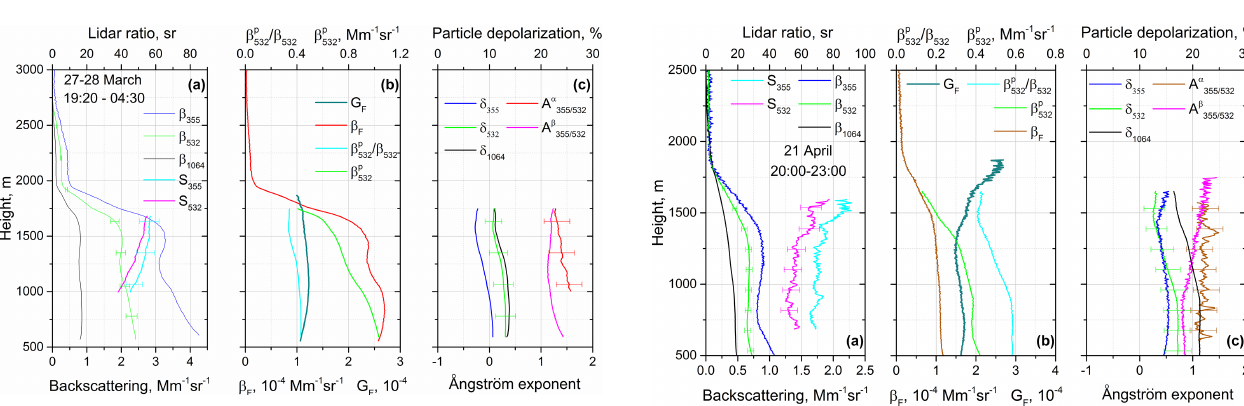
Figure 10. Vertical profiles of (a) particle backscattering coeffi- Figure 11. The same particle parameters as in Fig. 10 for 21 April cients β 355 , β 532 and β 1064 as well as lidar ratios S 355 and S 532 . 2020, 20:00–23:00UTC. Measurements were performed at 30 ◦ to (b) Fluorescence backscattering coefficient β F , fluorescence capac- the ity G F , pollen backscattering coefficient β p and its contribution to 532 β p 532 the total backscattering . (c) Particle depolarization ratios δ 355 , β 532 δ 532 and δ 1064 together with extinction A α and backscatter- 355 / 532 ing A β Ångström exponents measured on 27–28 March 2020 355 / 532 β p 532 were computed with at 19:20–04:30UTC. Profiles of β p and β 532 532 = 30% and δ b = 3%. the assumption that δ p 532 532